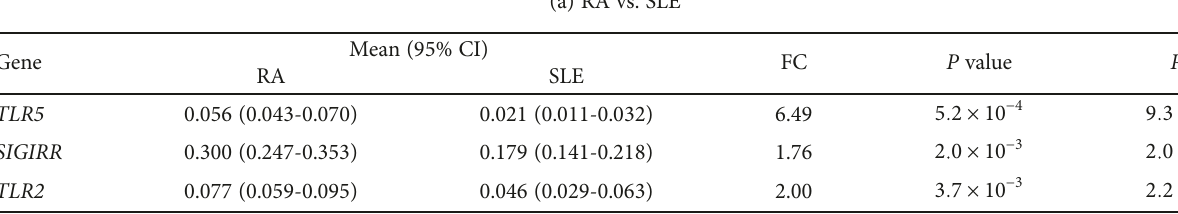
Table 2: Relative mRNA expression levels of genes di ff erentially expressed between (a) RA vs. SLE, (b) RA vs. SSc, (c) SSc vs. SLE. (a) RA vs.